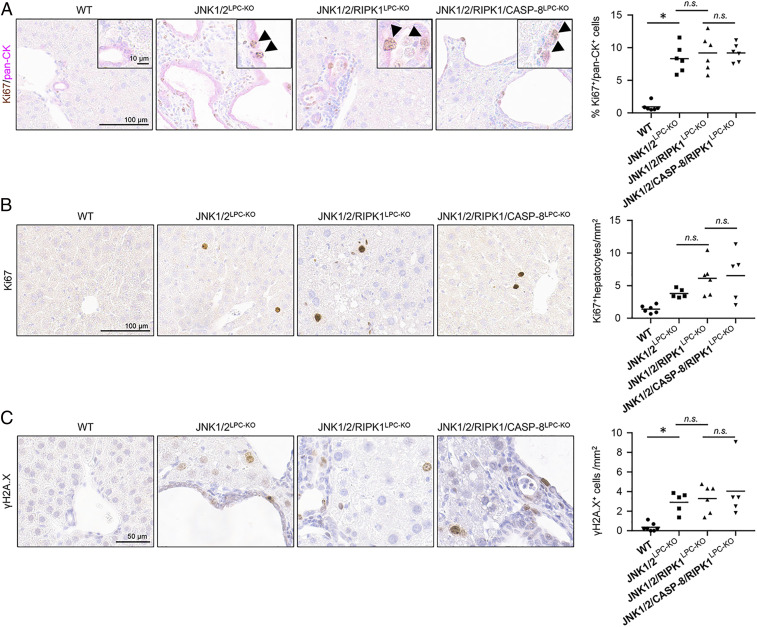
Additional deletion of Ripk1 in JNK1/2LPC-KO does not influence proliferation and DNA-damage response in cystic liver tissue. (A) Representative Ki67 (brown) and pan-CK (red) double stainings of liver sections of 52-wk-old WT, JNK1/2LPC-KO, JNK1/2/RIPK1LPC-KO, and JNK1/2/RIPK1/CASP-8LPC-KO mice and quantification of double-positive cells. n = 6. Arrowheads indicate double-positive cells. (B) Representative Ki67 stainings of liver sections of 52-wk-old WT, JNK1/2LPC-KO, JNK1/2/RIPK1LPC-KO, and JNK1/2/RIPK1/CASP-8LPC-KO mice and quantification. n = 5 or 6. (C) Representative ɣH2A.X stainings of liver sections of 52-wk-old WT, JNK1/2LPC-KO, JNK1/2/RIPK1LPC-KO, and JNK1/2/RIPK1/CASP-8LPC-KO mice and quantification. n = 5 to 7. *P < 0.05.